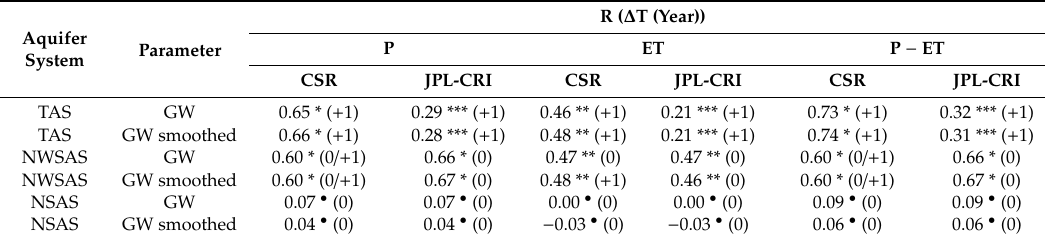
Table 3. Maximum of cross-correlation and time-lag ( ∆ T) between the annual average GW volume anomalies obtained using GLEAM 3.3b for SM and RL06 mascon GRACE-based TWS (CSR and JPL CRI) (and lake volume for NSAS) and the hydrological fluxes (P from TRMM 3B43, ET from GLEAM 3.3b and P–ET) in the TAS, NWSAS and NSAS over